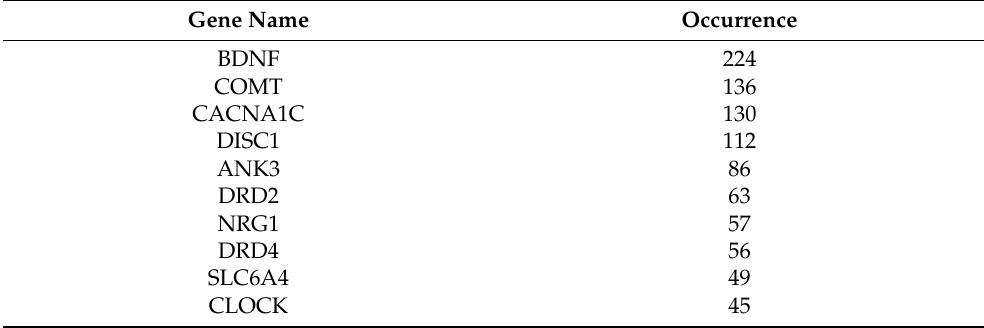
Table 2. Number of times specific genes have been represented in relationship with Bipolar Disorder. After receiving data from the code, the data were organized, and then